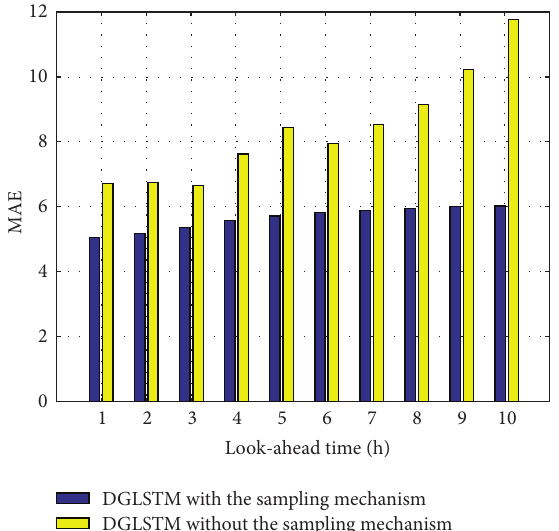
Figure 12: Influence of the sampling mechanism on the prediction